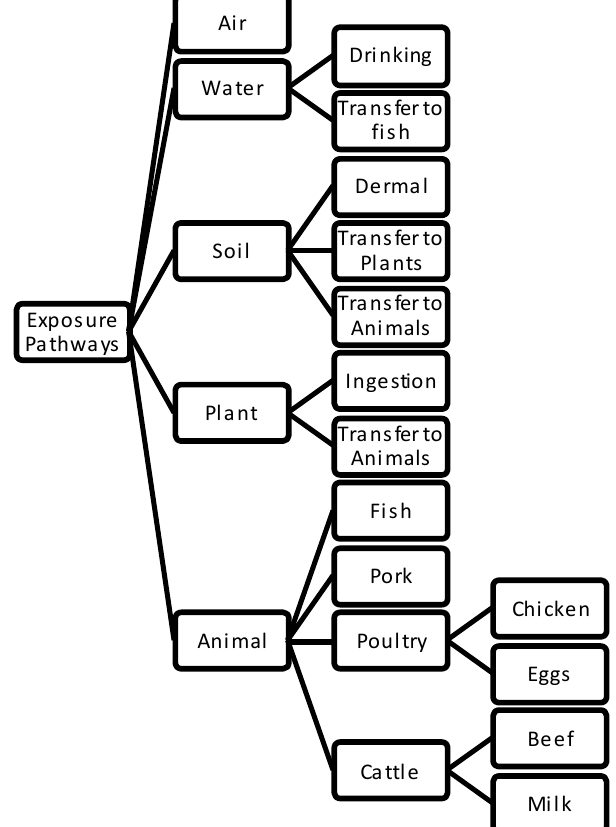
Figure 1. Direct and indirect exposure pathways considered in health risk assessment [23].